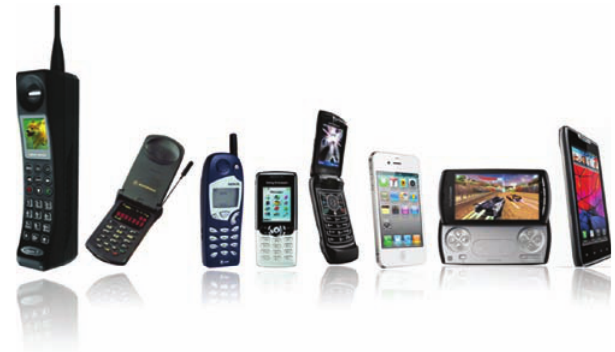
F 1: Mobile handheld phone examples through all the gener- ations.